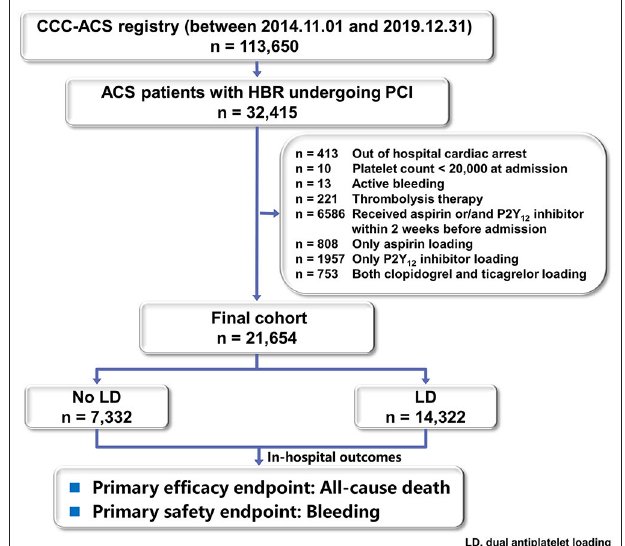
FIGURE 1 | Study flow